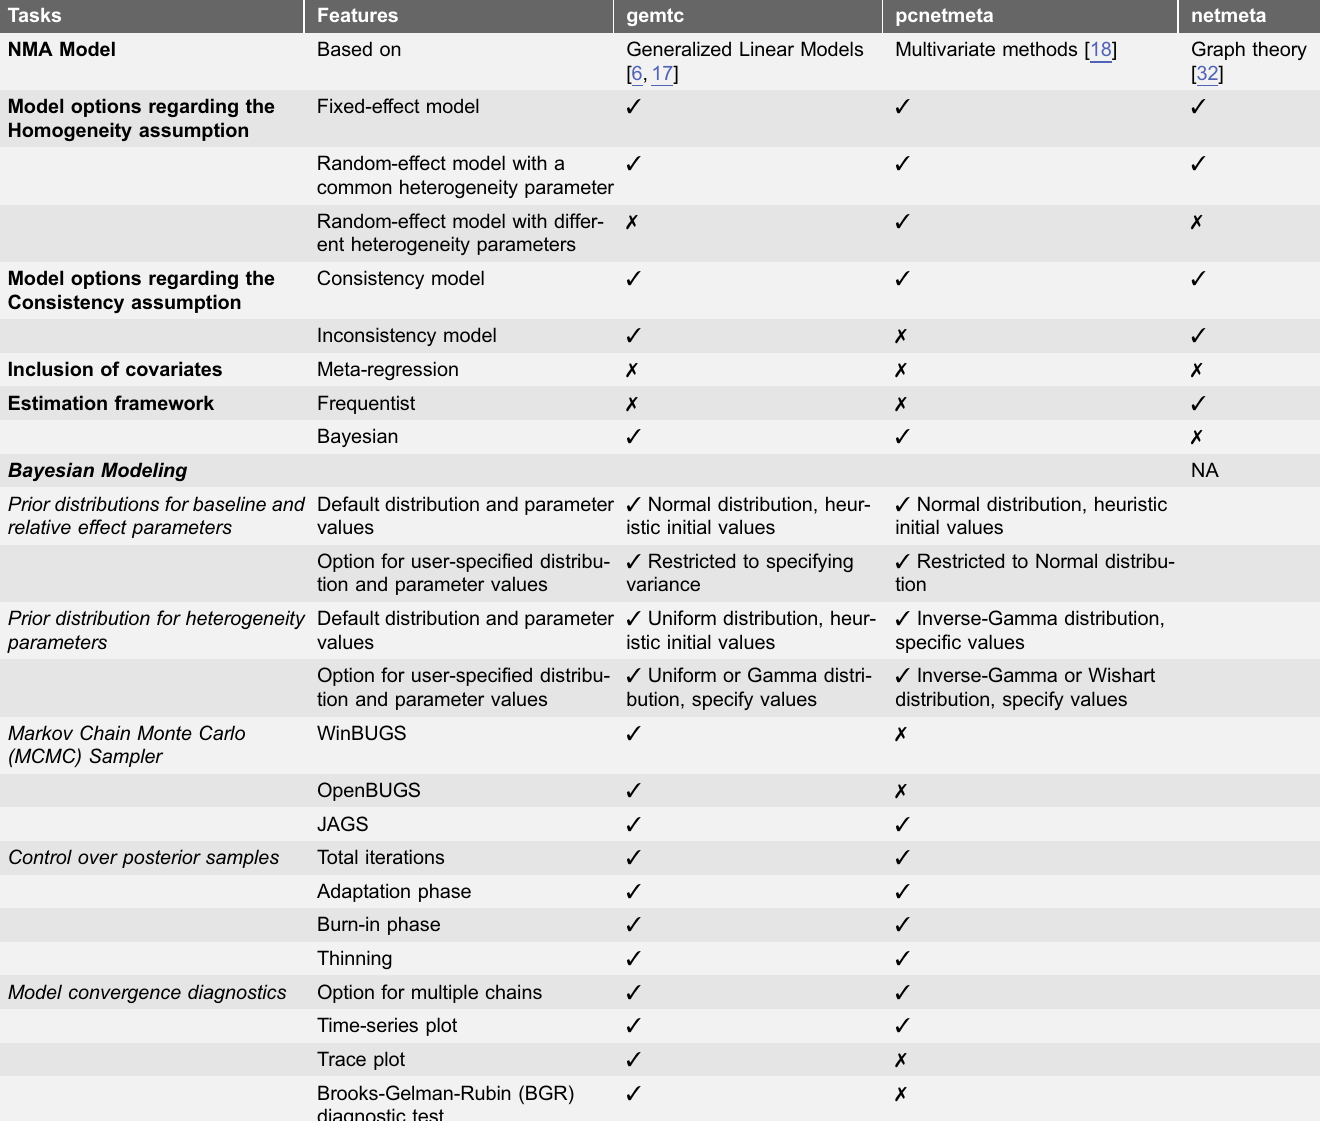
Table 2. Modeling options from NMA R packages gemtc, pcnetmeta and